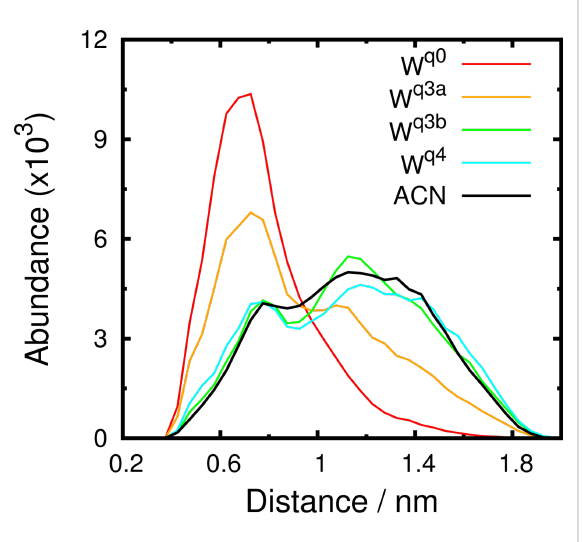
We also calculated the histogram of the distance between the center of mass of the last 4 atoms of the carbon chain of the mannoside and the 6 atoms of the phenyl ring (Figure 8). These histograms show a clear preference for lower distances in water for the fully deprotonated state (W q0 ). In W q0 , the interaction